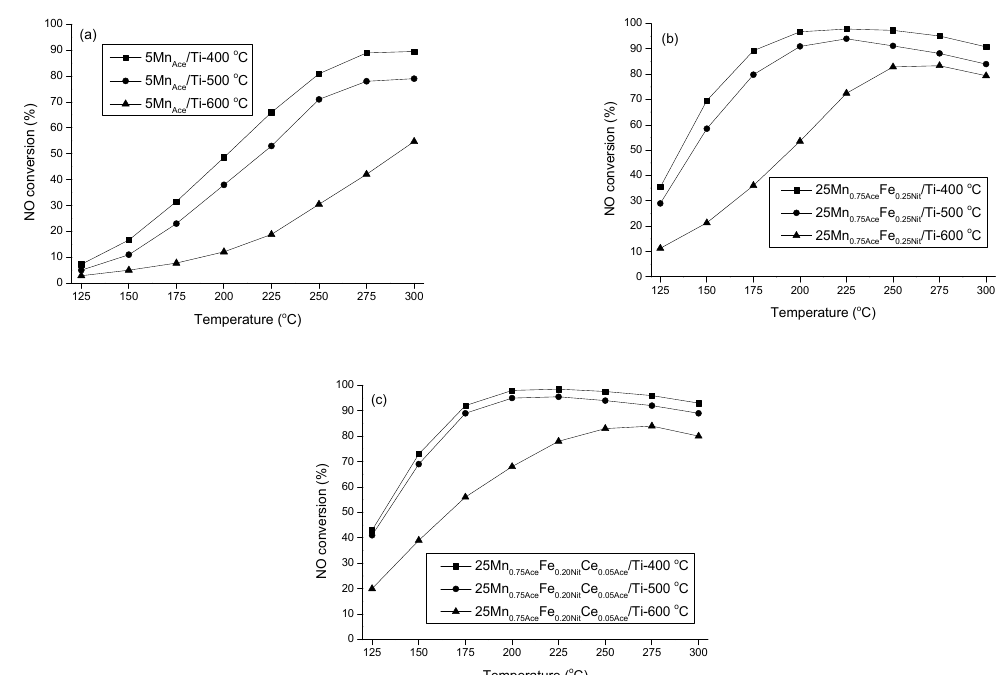
Figure 8. NO conversion profiles of catalysts calcined at various temperatures: ( a ) 5MnAce/Ti; ( b ) 25Mn 0.75Ace Fe 0.25Nit /Ti; and ( c ) 25Mn 0.75Ace Fe 0.20Nit Ce 0.05Ace /Ti.